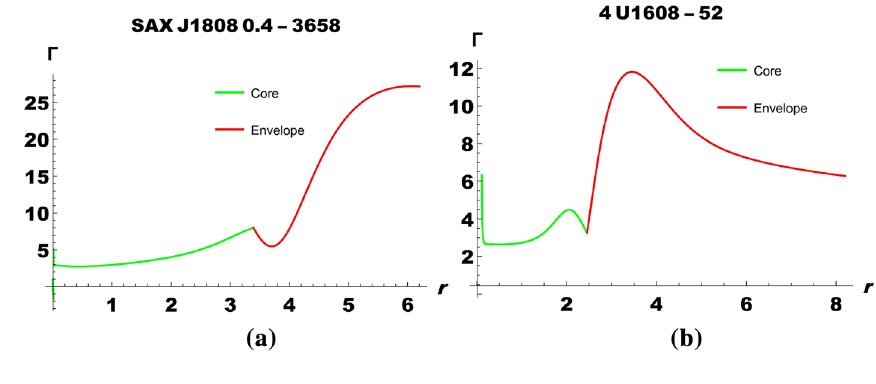
conditions with radial